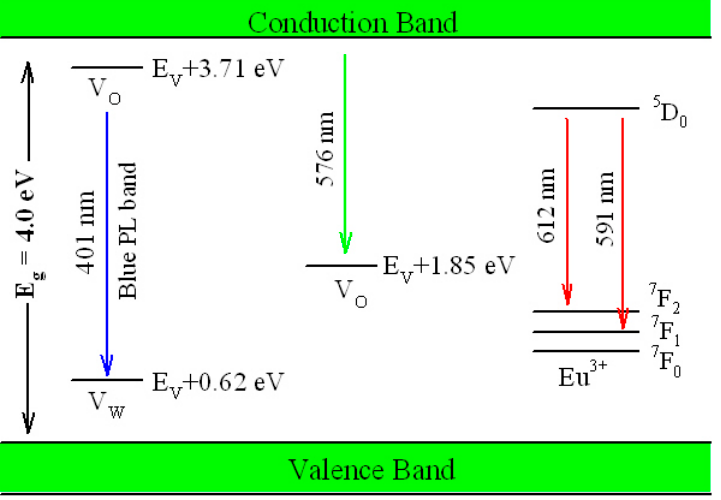
Figure 17. Possible mechanisms of tunable PL from in Eu-doped ZnWO 4 .